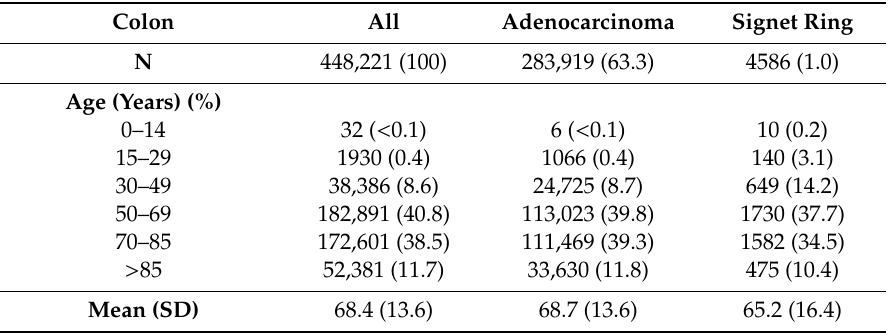
Table 3. Baseline demographics and clinical characteristics by histology for colon